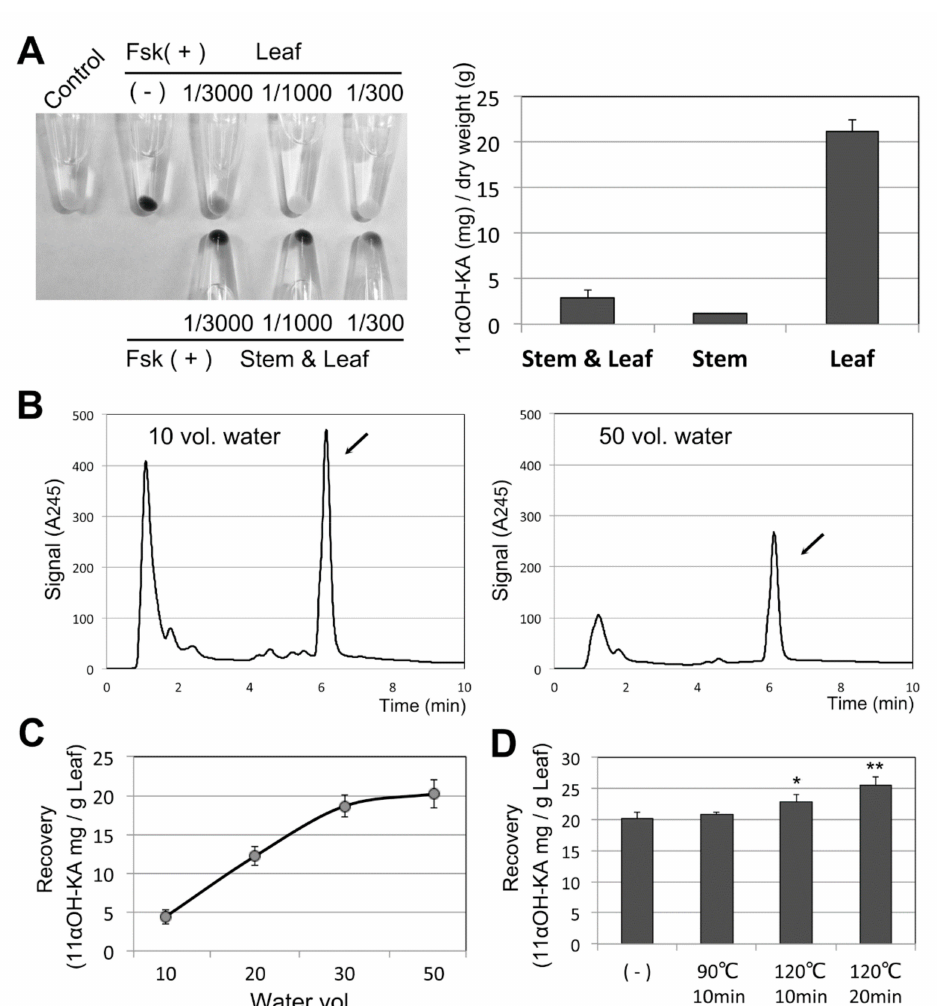
Figure 3. ( A ) Leaves alone and with stems were dried and extracted with 20 volumes of water. B16F10 cells were treated with these extracts at the indicated dilution (left). One gram of dried A. lavenia (di ff erent portions) was extracted twice with 20 volumes of water, and the 11 α OH-KA content was measured (right). The means and SD are indicated, n = 3. ( B ) LC-UV analysis of A. lavenia leaves extracted with 10 volumes (left) and 50 volumes (right) of water. Arrows indicate 11 α OH-KA. ( C ) One gram of dried A. lavenia leaf was extracted once with the indicated volumes of water, and the recovery of 11 α OH-KA was calculated after the LC-UV analyses ( n = 2). ( D ) Extracts (30 volumes of water) were incubated at the indicated temperatures and times, with the analyses performed by LC-UV. * and ** indicate p < 0.05 and p < 0.01, respectively ( n = 3